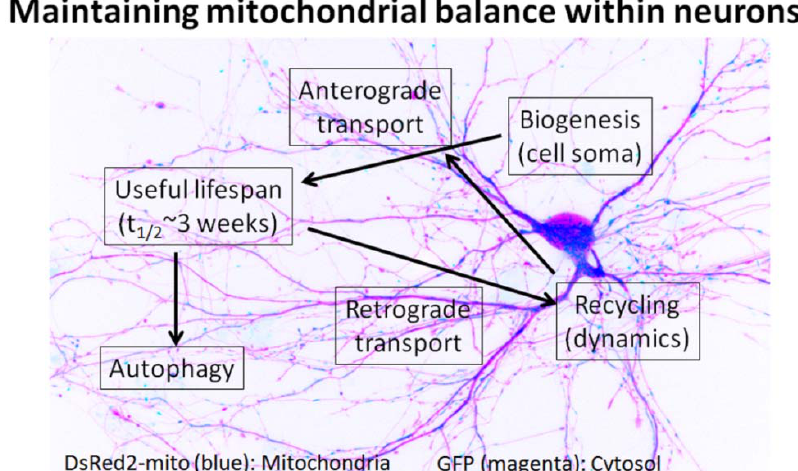
Figure 1. Primary hippocampal neuron with mitochondria labeled by MitoDsRed2 and cytosol labeled by GFP. The figure illustrates the mitochondrial lifecycle, including biogenesis, mitochondrial transport, and synaptic localization and degradation. Because of neuronal architecture with long processes and high energetic demands at distal regions of the cell, mitochondrial distribution is critical to the survival of neurons. Disruptions in regulating several aspects of mitochondrial biology are known to lead to